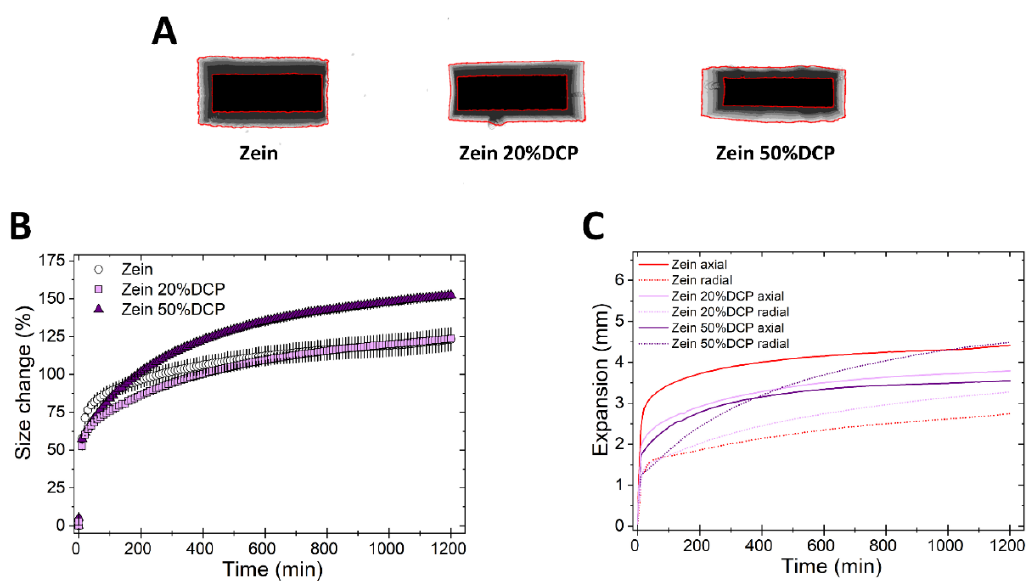
Figure 4. Swelling of tablets made of binary mixtures of zein and DCP (20% and 50% w / w ). ( A ) Sum of Z-stack of images. The two red lines are the outlines of the tablet at time 0 and at 20 h. ( B ) Swelling measured as the change of the projected area of tablets (mean ± SD, n = 3) as a function of time. ( C ) Axial and radial swelling of tablets (mean ± SD, n = 3) as a function of time. Pharmaceutics 2019 , 11 , x FOR PEER REVIEW